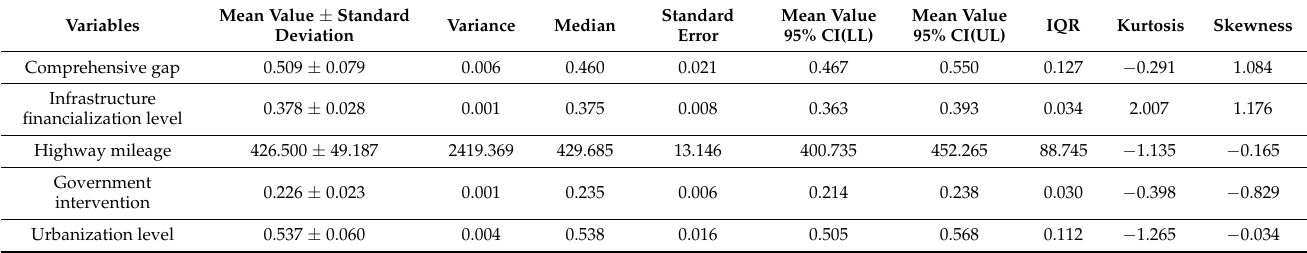
Table 1. Descriptive statistics of variables.